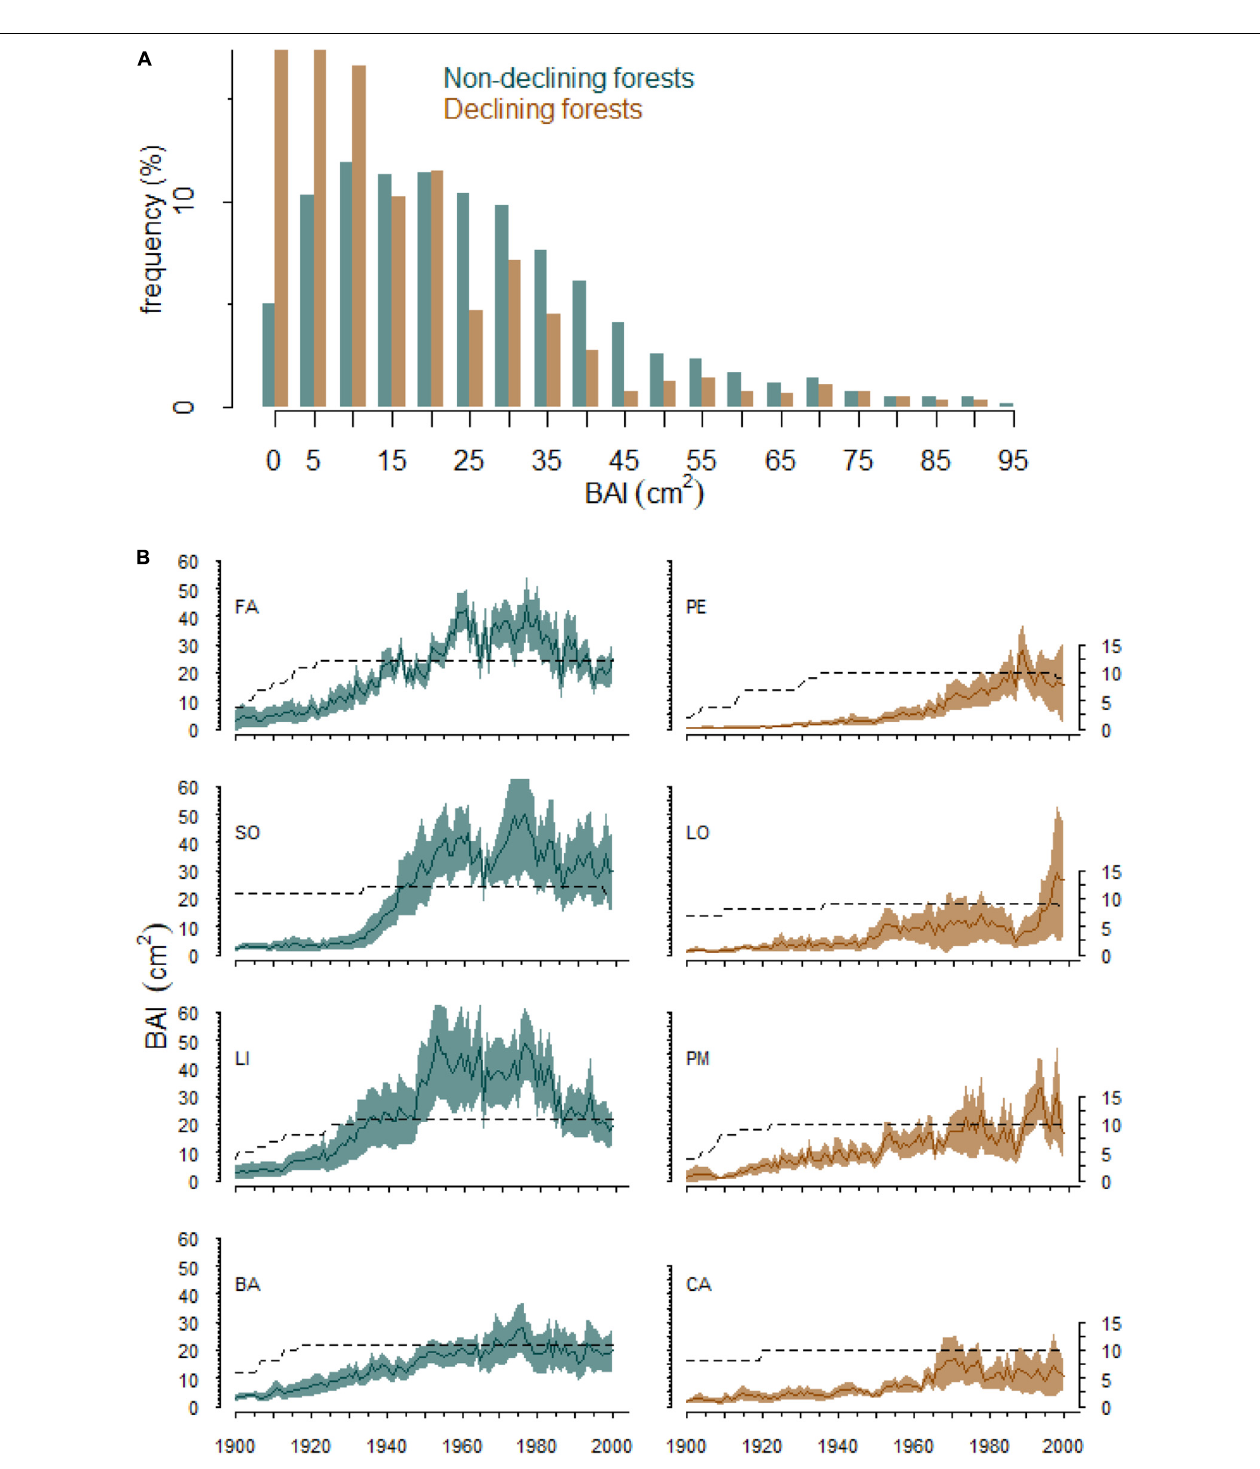
FIGURE 2 | Growth (BAI, basal area increment) comparisons between non-declining and declining Silver fir trees (A) and trajectories of selected non-declining silver fir forests (FA, SO, LI, and BA sites) and those showing dieback (PE, LO, PM, and CA sites) (B) . The dark line represents the average BAI over all the individuals sampled in the stand and the shaded areas show the 95% confidence intervals for the mean. The dashed line (secondary right y axis) represents the number of trees sampled in each stand. Blue and brown colors are used to differentiate the non-declining from declining stands showing dieback respectively.